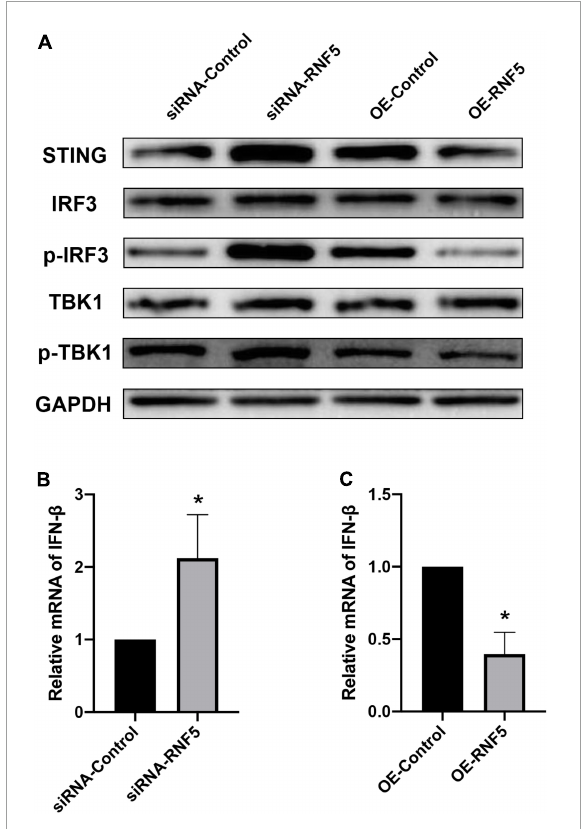
FIGURE3 RNF5 inhibits the expression of IFN- β through the STING/IRF3 signaling pathway. (A) HCECs were inoculated with HSV-1 after the silencing or overexpression of RNF5, and the relative expression levels of STING, IRF3, p-IRF3, TBK1, and p-TBK1 were detected using Western blotting at 12 h after the infection. (B) HCECs were inoculated with HSV-1 after RNF5 silencing, and 12 h after the infection, the expression of IFN- β mRNA was detected using quantitative PCR. (C) HCECs were inoculated with HSV-1 after inducing RNF5 overexpression, and the expression of IFN- β mRNA was detected using quantitative PCR at 12 h after the infection. Data are shown as the mean ± SD of three independent experiments. * P < 0.05.